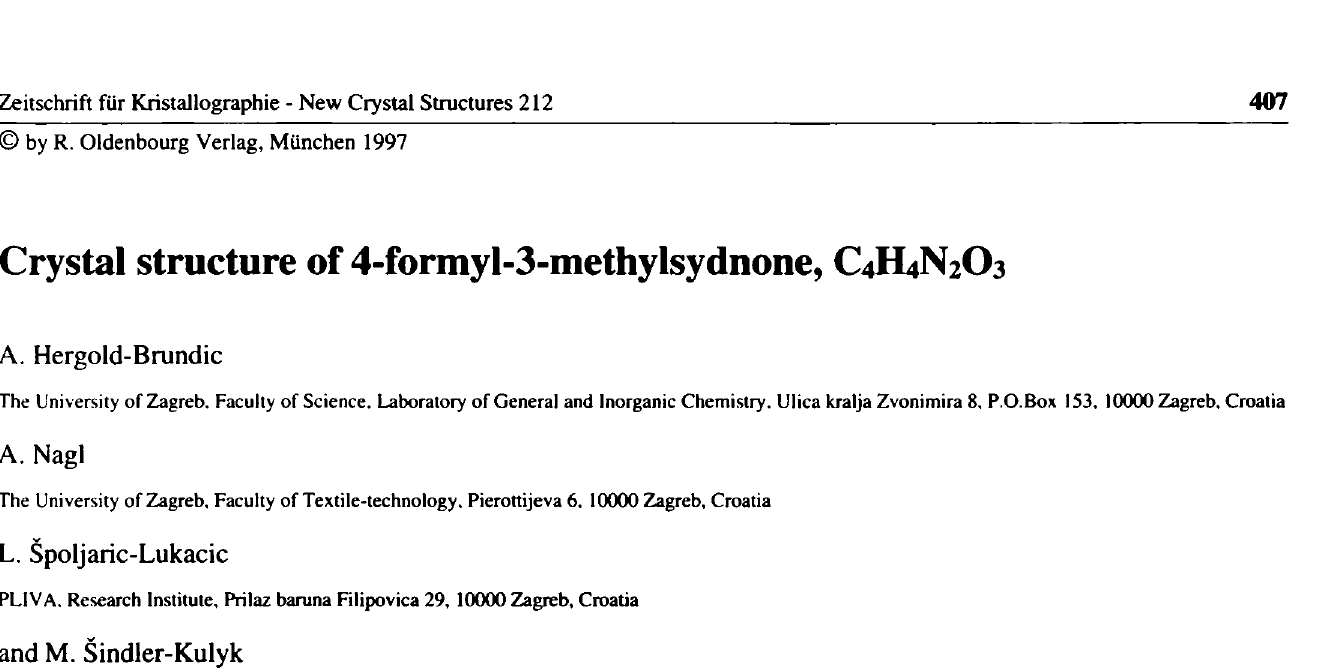
Table 1. Parameters used for the X-ray data collection